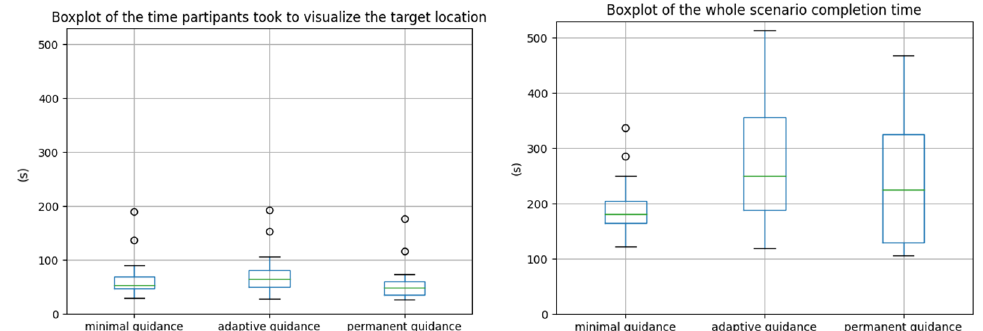
Figure 5. Boxplots by guidance type. On the left is the boxplot of the time participants took to visualize the target location and on the right is the boxplot of the time participants took to complete the whole scenario. Participants were significantly slower to find the target location with the adaptive guidance than with the permanent guidance. Participants were significantly faster